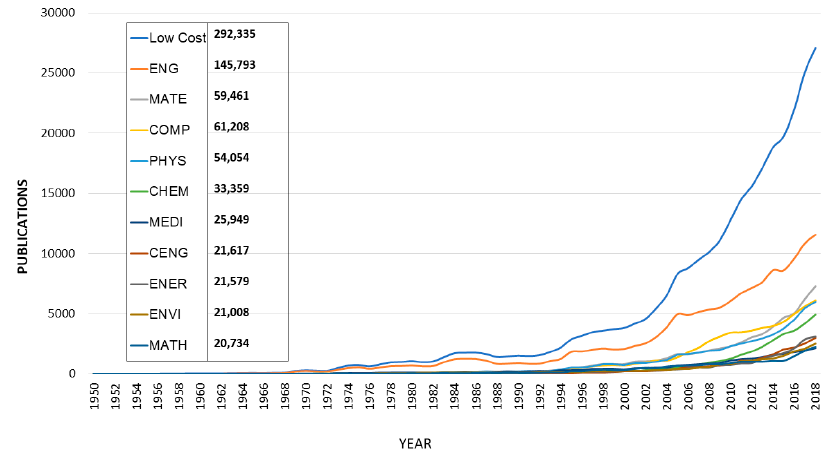
Figure 3. Temporal evolution of low-cost publications by scientific categories indexed in Scopus.